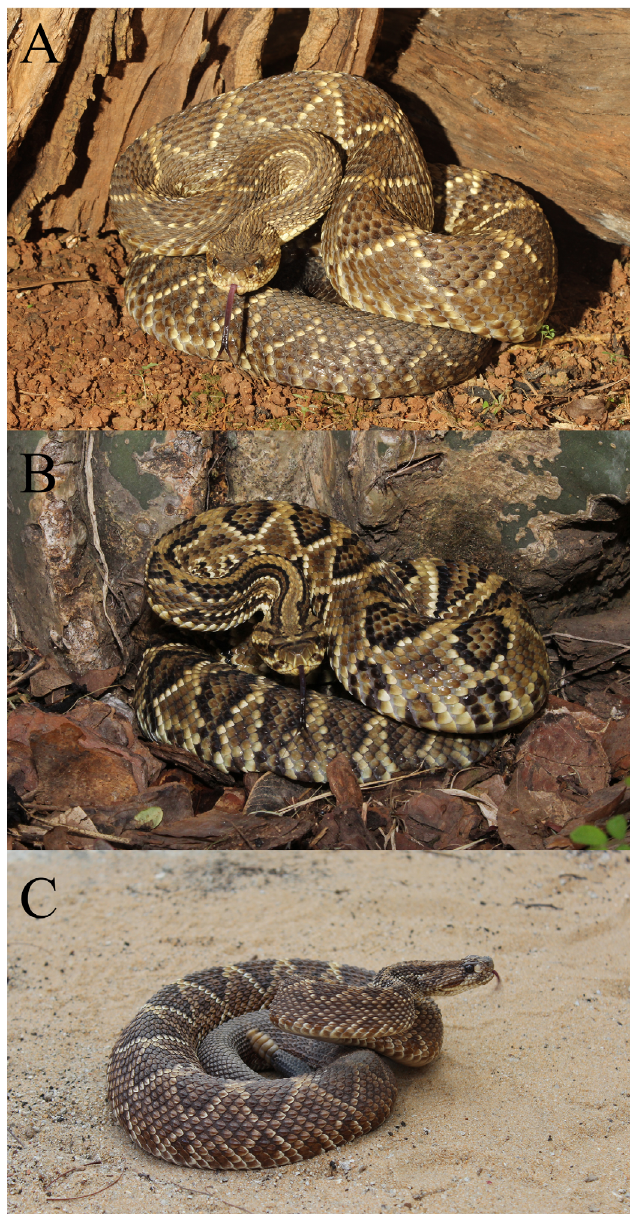
Figure 1. Subspecies of Crotalus durissus analyzed in the present study: (A) C. d. terrificus , (B) C. d. collilineatus , and (C) C. d. cascavella